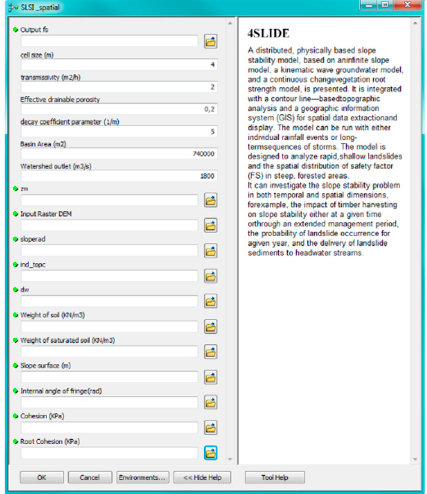
Figure A1. Flow chart of model development procedure. Figure S1. Flow chart of model development procedure. Figure S1. Flow chart of model development procedure.